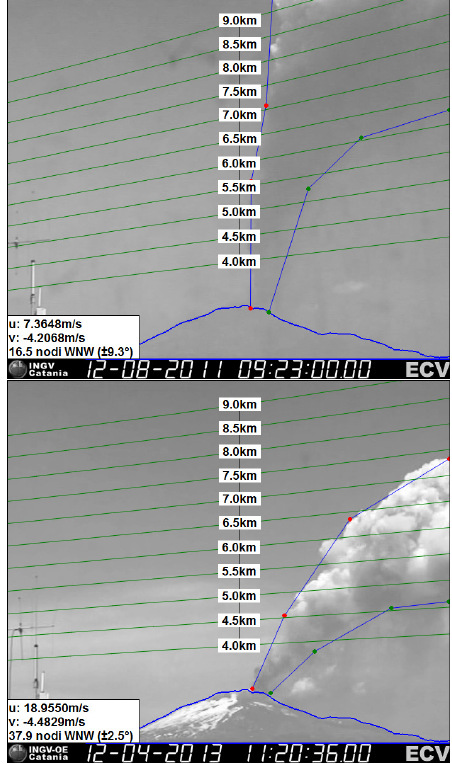
Figure 2. Two examples of the calibrated ECV images used to es- timate the height. The green lines indicate the height a.s.l. The line angle is function of the wind